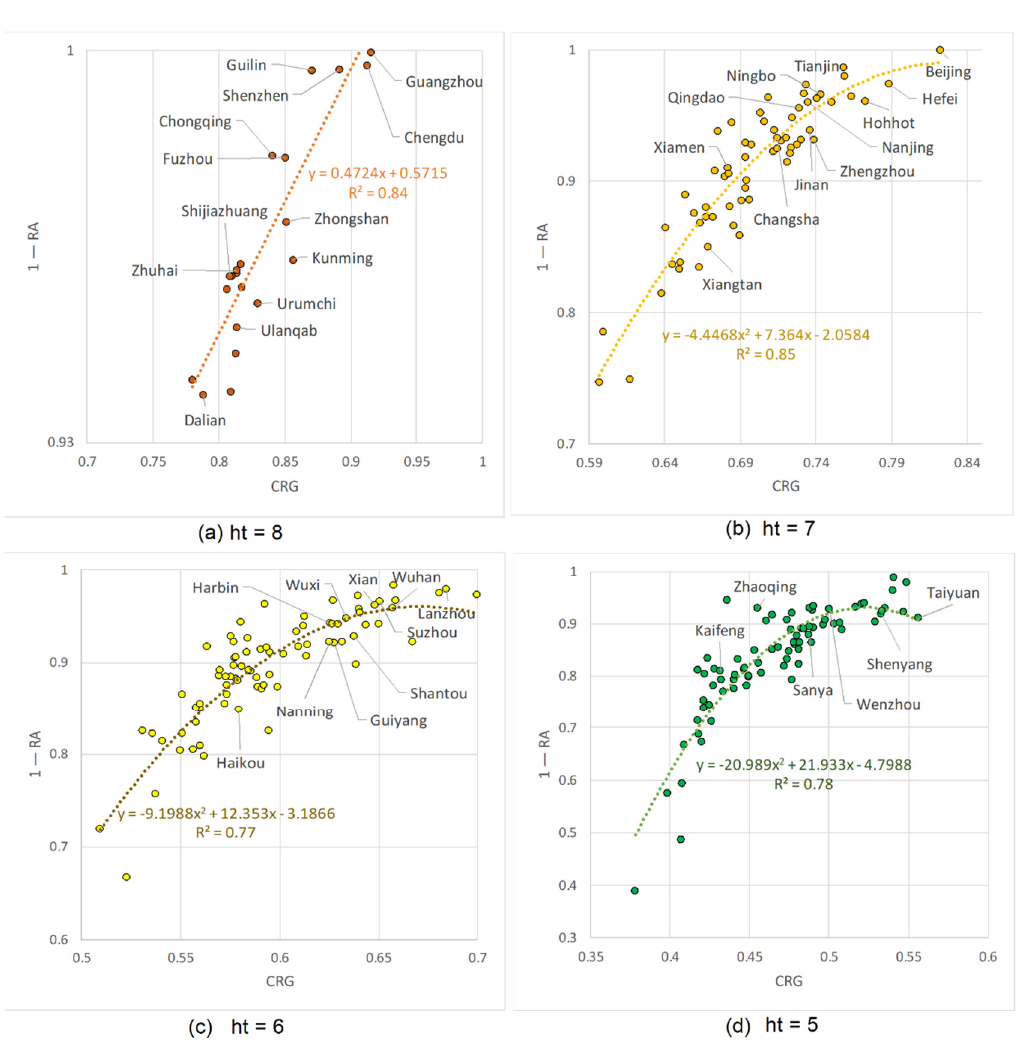
Figure 7. (Color online) The correlation between CRG and RA for cities with the same ht-index. Note: Panels ( a ), ( b ), ( c ), and ( d ) are correlations with the ht-index of 8, 7, 6, and 5, respectively.